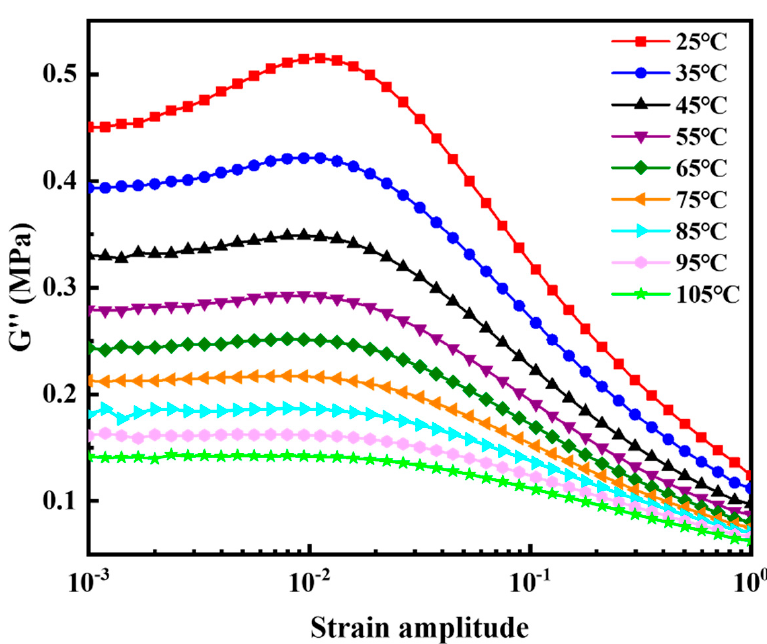
Figure 8. The dependence of loss modulus on strain amplitude at different temperatures. The strain sweeps from a small strain of 0.1% to a big one of 100%. Temperature scans from 25 °C to 105 °C in 10 °C intervals.